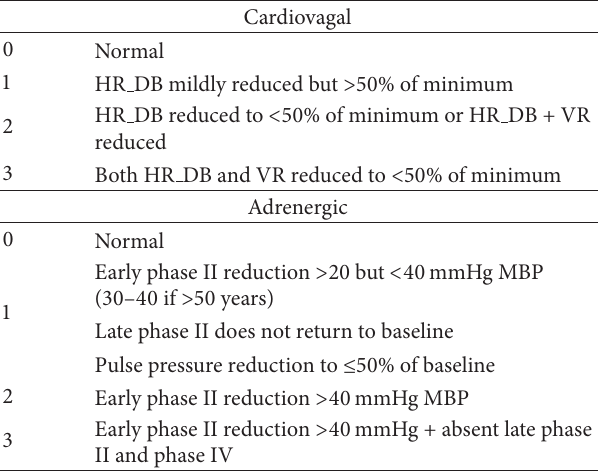
Table 1: Modified Composite Autonomic Scoring Scale (subscores in cardiovagal and adrenergic